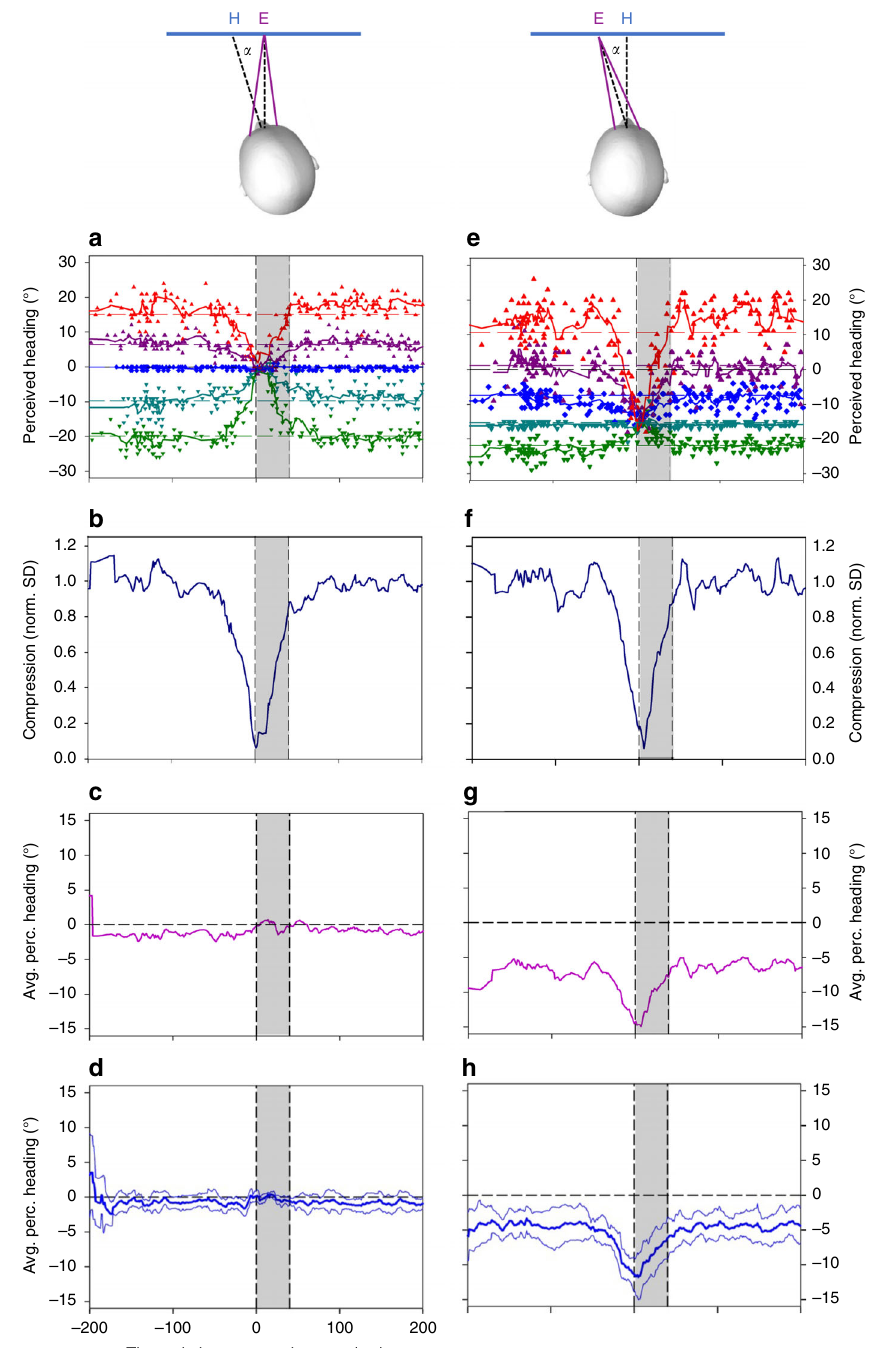
Fig. 10 Reference frame of the compression of the representation of heading. Single-subject data. The subject performed a 10° upward saccade, and we presented a 40 ms long self-motion sequence. In a , e , each colored data-point indicates the onset of the self-motion sequence ( x -value) and the perceived heading ( y -value). The colored horizontal dashed lines in a , e indicate the subject ’ s mean heading perception for a given stimulus direction during steady fi xation. The subjects ’ head was either a directed α = 15° to the left, while gaze was still straight ahead (i.e., aligned with the body- and screen-midline), or e the head was straight ahead, but eyes were directed α = 15° to the left. We observed a perisaccadic shift of perceived heading toward the screen center in the fi rst case (head to the left, a ), but a shift toward − 15°, when the eyes were directed to the left ( e ). The time course and strength of compression were identical in both cases ( b , f ). We determined also the time course of the average perceived position, i.e., the time course of the mean of all fi ve heading percepts, which was rather stable over time in the head-turned condition ( c ). In the gaze-turned ead-straight condition, however, also long before and after the saccade, perceived heading was biased away from straight ahead, toward the direction of gaze. In the temporal vicinity of the saccade, the averaged perceived heading was in line with the direction of gaze ( g ). At the time of maximum compression, all headings were perceived as being 15° to the left. The fi ndings for this subject were representative for the group of subjects, as indicated in d , h . The thick blue line indicates the time-resolved average value of perceived heading across all fi ve subjects. The thin blue lines indicate the time-resolved standard